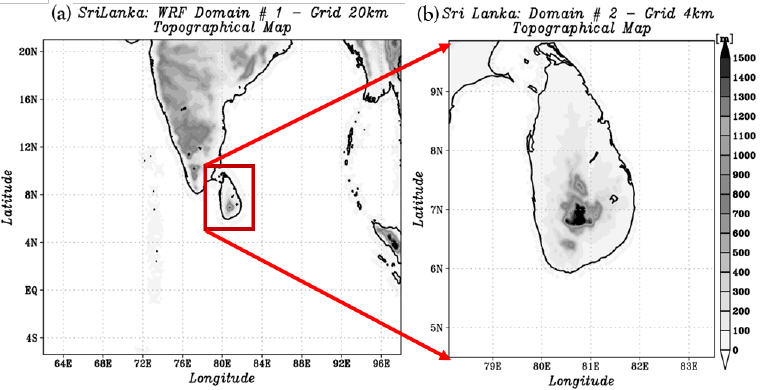
Figure 4. Model domains and topographical map used for numerical weather forecasting: ( a ) the outer domain at 20 km grid resolution and ( b ) the inner domain at 5 km grid resolution.